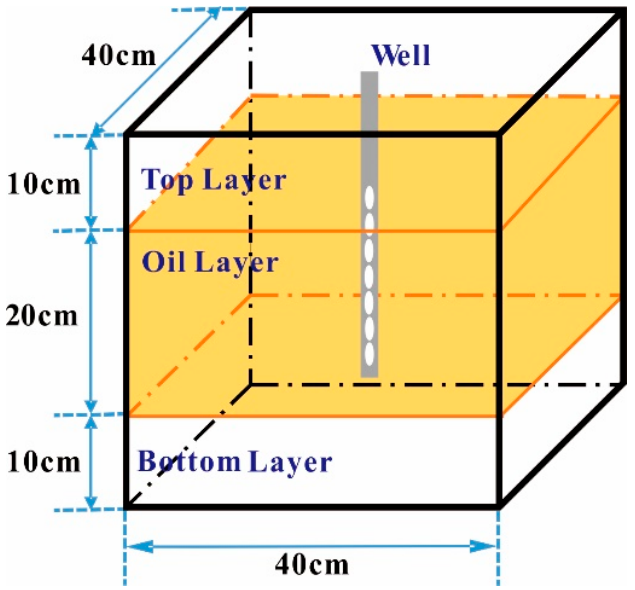
Figure 3. Schematic diagram of three-dimensional physical model.